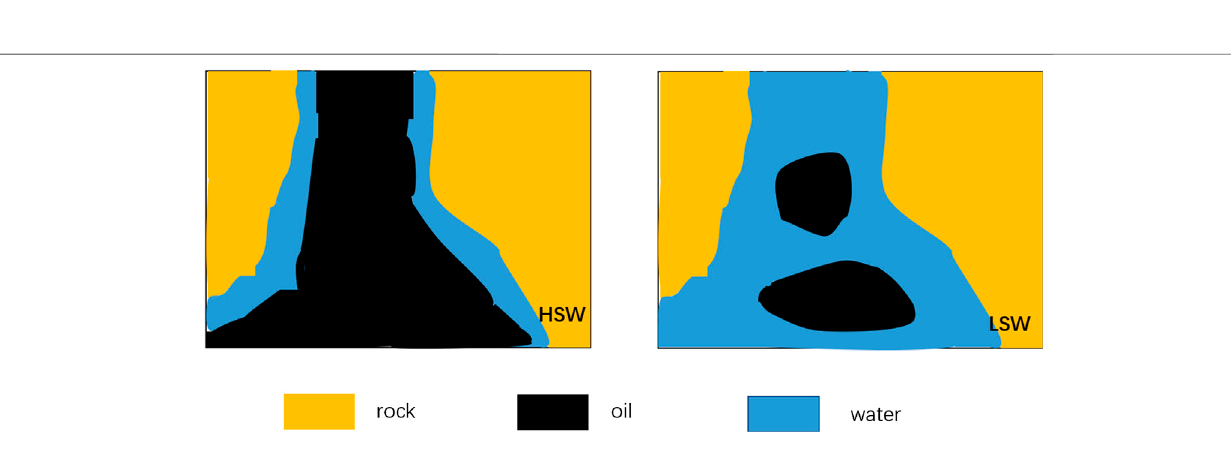
FIGURE 9 | Schematic of oil distribution in HSW and LSW fl